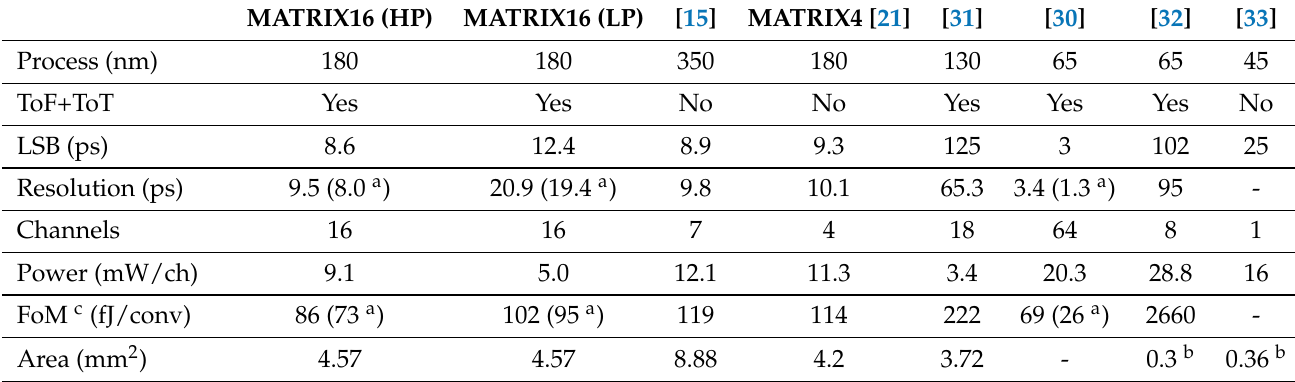
Table 3. MATRIX16 performance summary and comparison with recent proposals. a After calibration. b Core area (not full chip size). c Figure-of-Merit = Resolution · Power